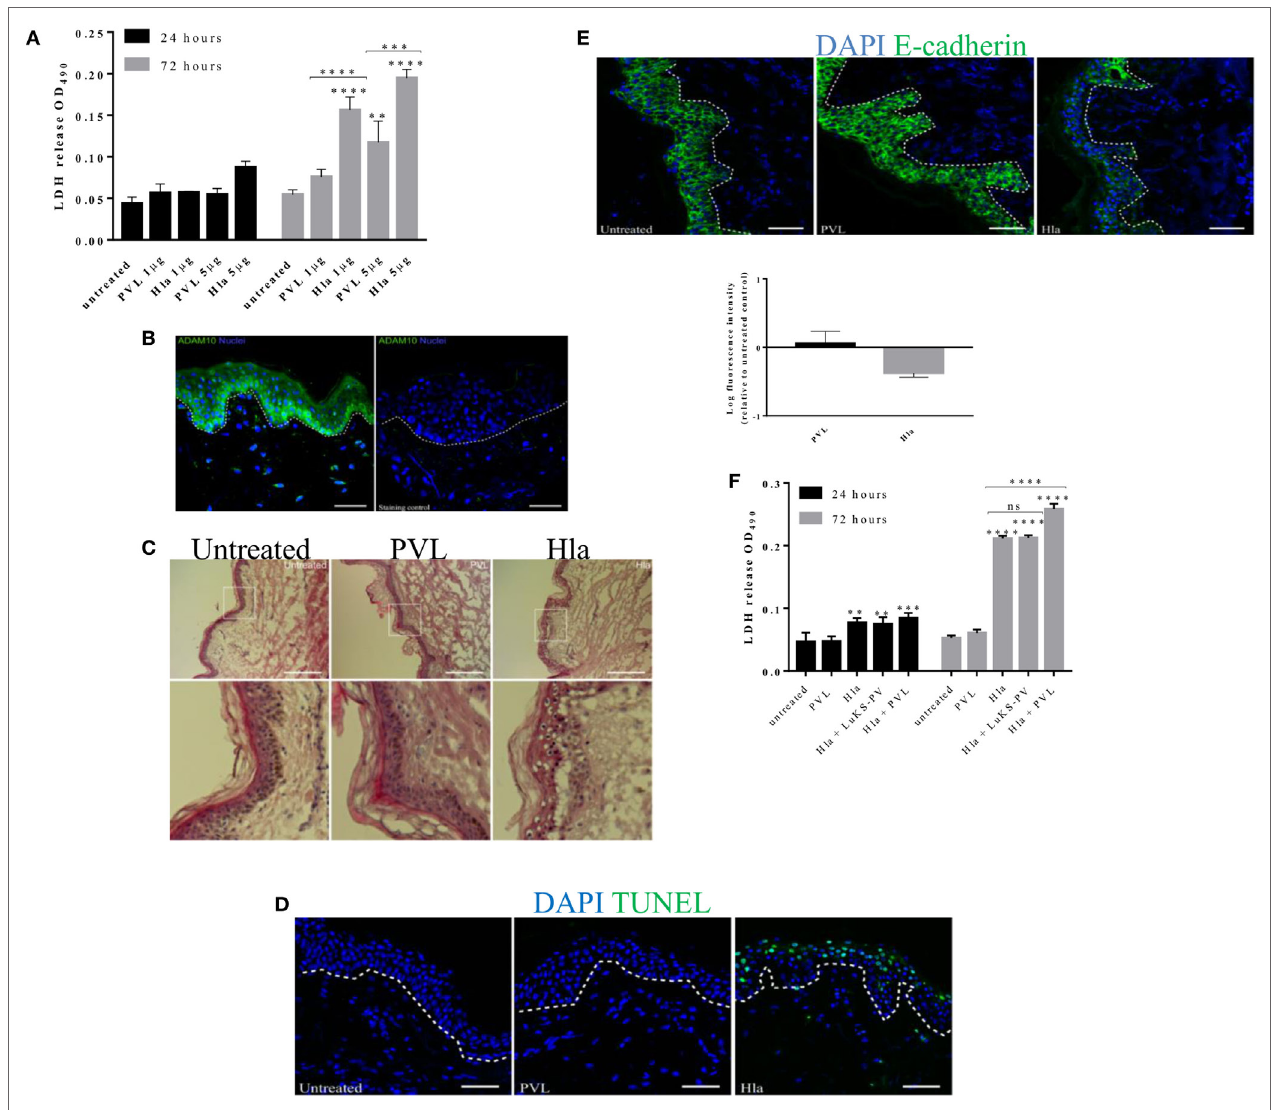
FigUre 2 | The role of Hla and Panton–Valentine leukocidin (PVL) in tissue toxicity and disruption of skin integrity. Human skin explants were treated with 1 and 5 µg of α -toxin or PVL and a cocktail of both toxins at 1 µg each. (a) Lactate dehydrogenase (LDH) released from human skin during 24–72 h of treatment with staphylococcal toxins. Data are combined results from three independent experiments Each bar represents the mean ± SD, N ≥ 2 for each experiment. Where N ≥ 2 represents intra-experimental replicates. (B) Immunofluorescence image of human skin section showing the expression of ADAM10 within the layers the epidermis. Scale bar 50 µm. (c) Hematoxylin and eosin staining of skin cryosections taken 24 h post toxin treatment. White box represents a magnified area of the image. Scale bar is 100 µm. (D) Cryosections of human skin explant showing TUNEL-positive cells (in green) after 24 h treatment with Hla or PVL. Scale bar 50 µm. (e) Immunofluorescence images of E-cadherin signal on skin cryosections 24 h post toxin stimulation. Scale bar 50 µm. (F) LDH released from human skin during 24 and 72 h of treatment with a cocktail of Hla and PVL at 1 µg each. Each bar represents the mean ± SD ( N = 3). Statistical analysis was performed by two-way ANOVA, with Tukey’s multiple comparison tests, ** p ≤ 0.001, *** p ≤ 0.0002, and **** p < 0.0001. Asterisks on bars are a comparison between the treated and untreated skin while lines across bars are comparison between groups. White dotted lines in images represent the boundary between epidermis and